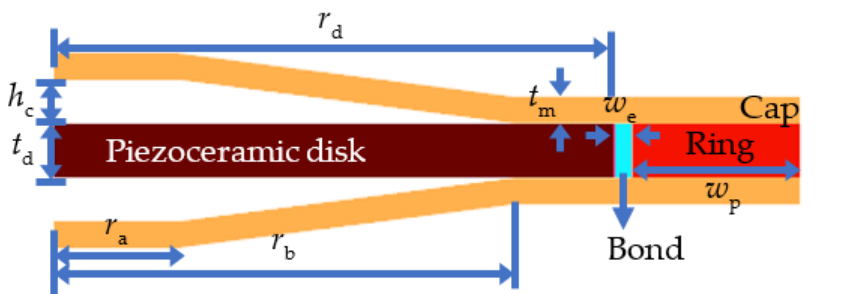
Figure 1. Finite element model of the cymbal transducer.